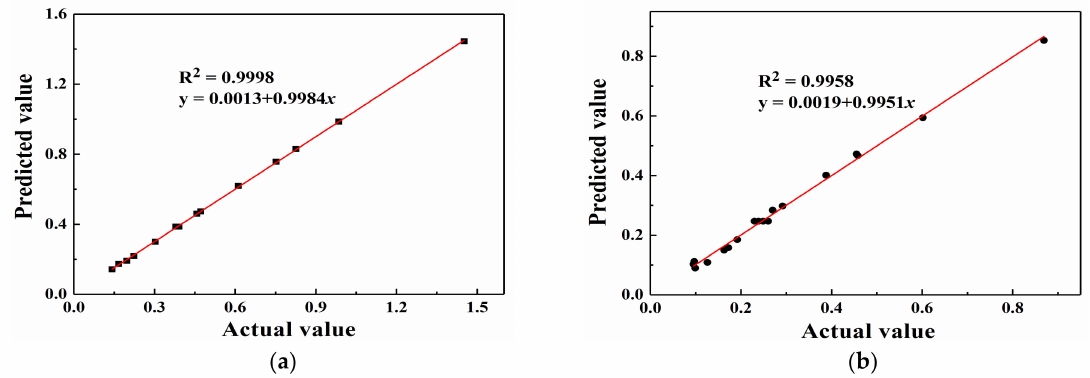
Figure 7. Comparison of the predicted and actual values: ( a ) A 1 and ( b ) A 2 .